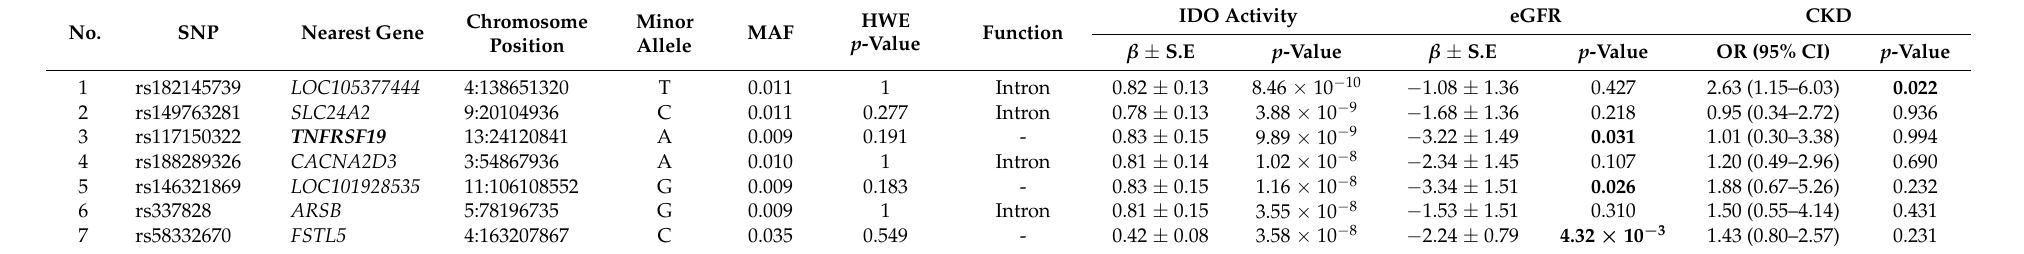
Table 3. Rare variants associated with indoleamine 2,3-dioxygenase activity in